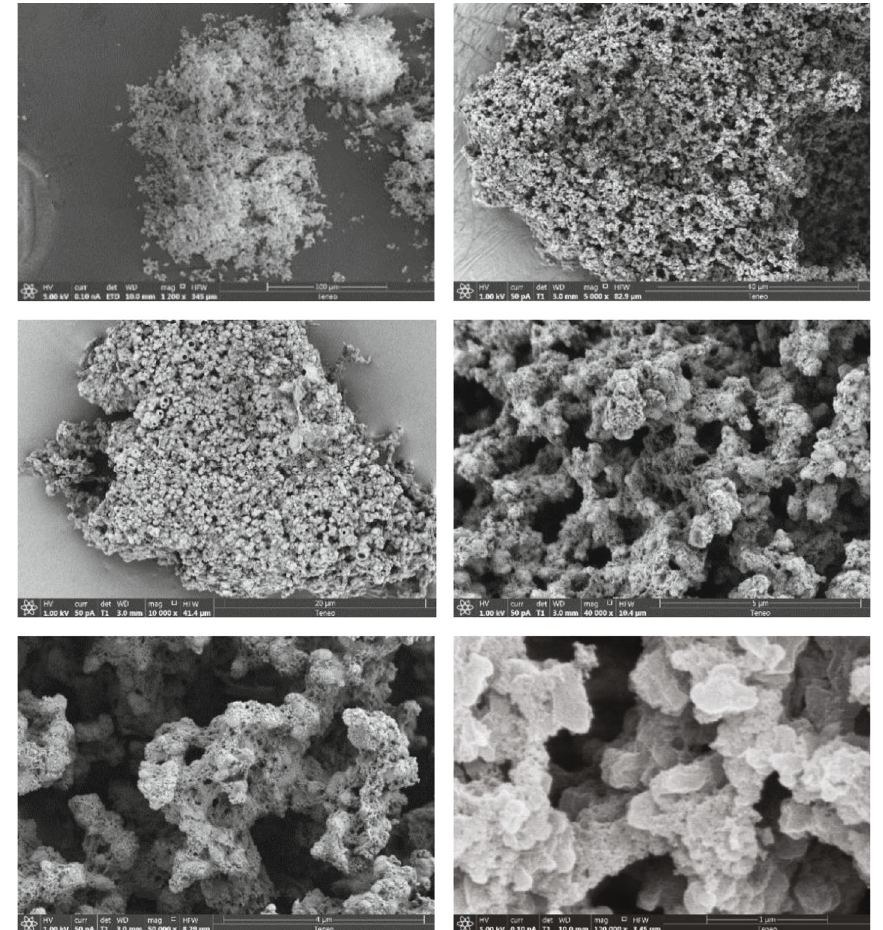
Figure 4: SEM micrographs for C-PMMA/Mel2 at di ff erent magni fi